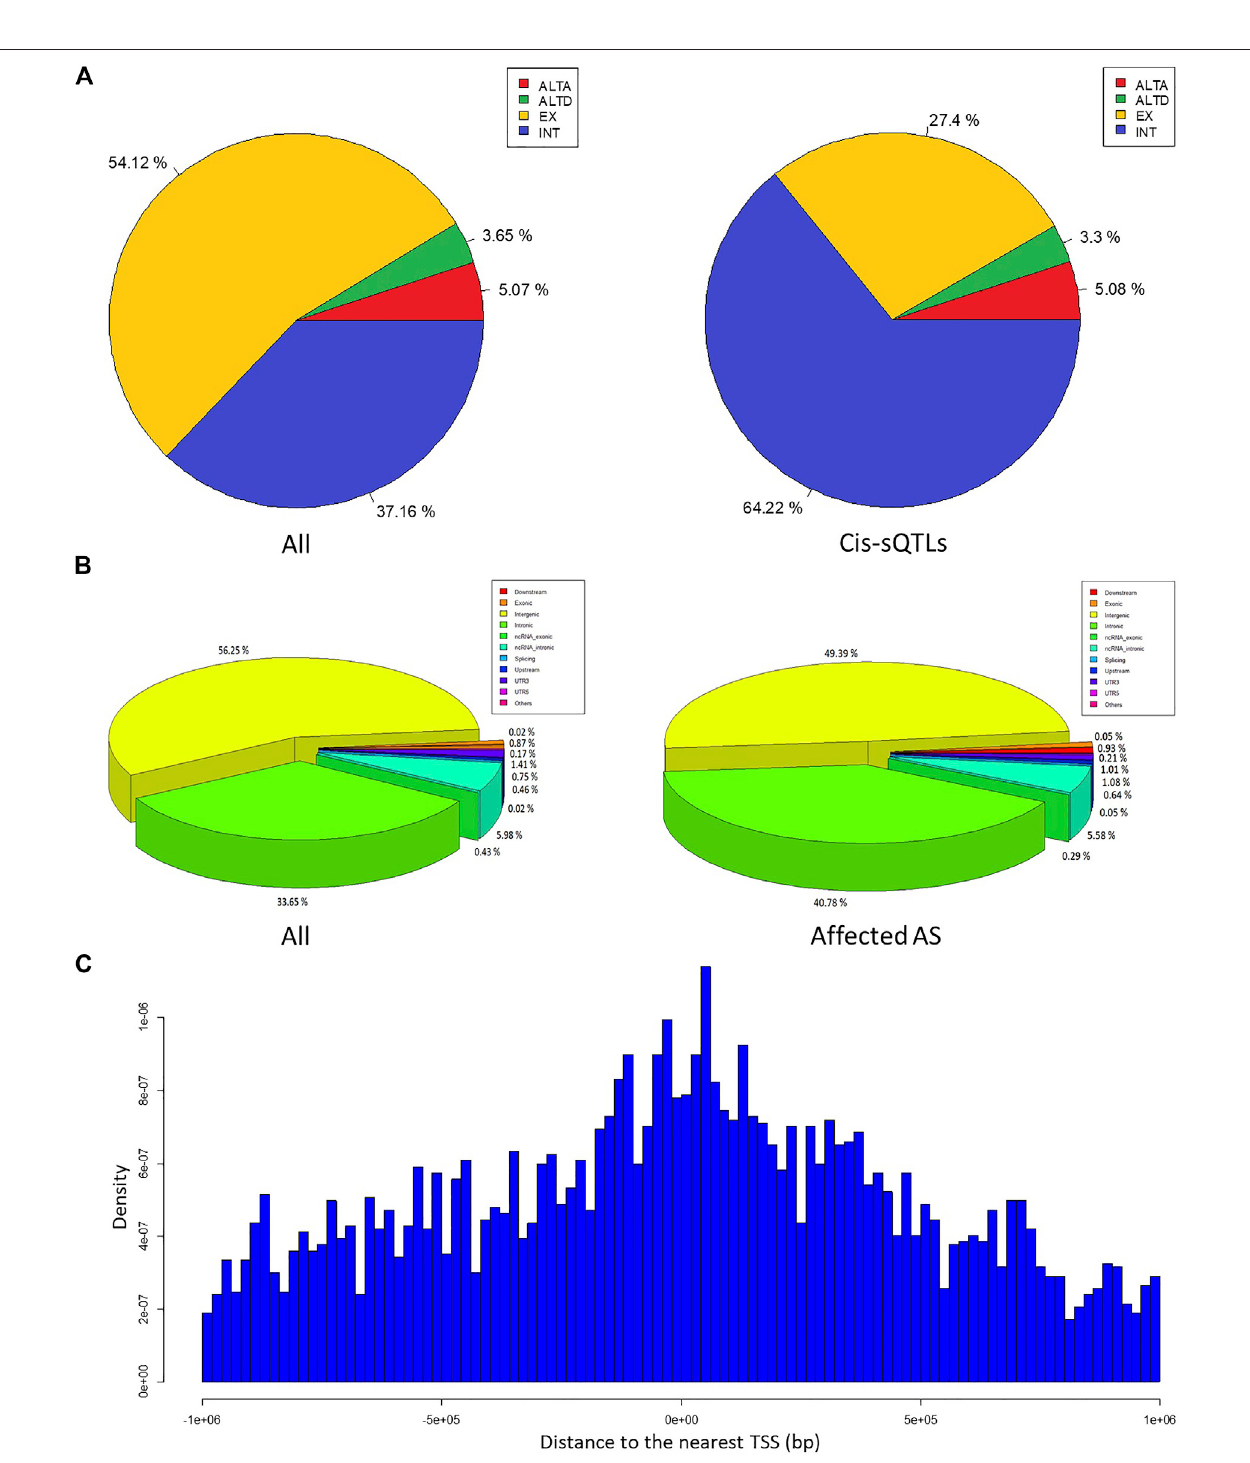
FIGURE2| Thecharacteristicofthe cis -sQTLvariantsandtheaffectedASevents. (A) Thepiechartsshowthepercentageofallvariants(left)and cis -sQTLvariants (right) annotated with each class (intergenic, intronic, exonic, ncRNA intronic, ncRNA exonic, 5 ′ /3 ′ -UTR, upstream/downstream, splicing site, and others), respectively. (B) ThepiechartsshowtheproportioninallASevents(left)andaffectedASevents(right)annotatedwitheachclass(EX,INT,ALTA,andALTD),respectively.( C )Thebar graph indicates the relationship between the abundance of the cis -sQTL variants and the distance of them to the nearest TSS of AS events corresponding genes.